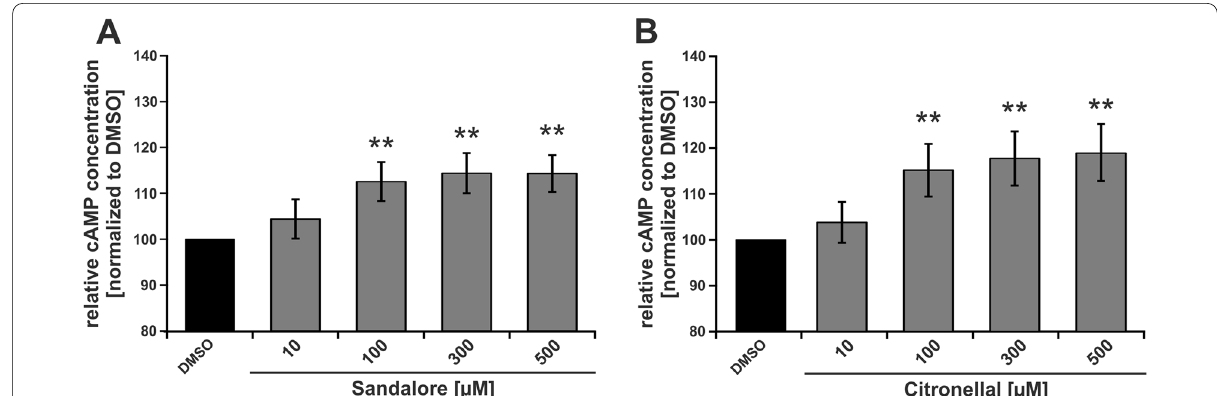
5 donors) are presented as =